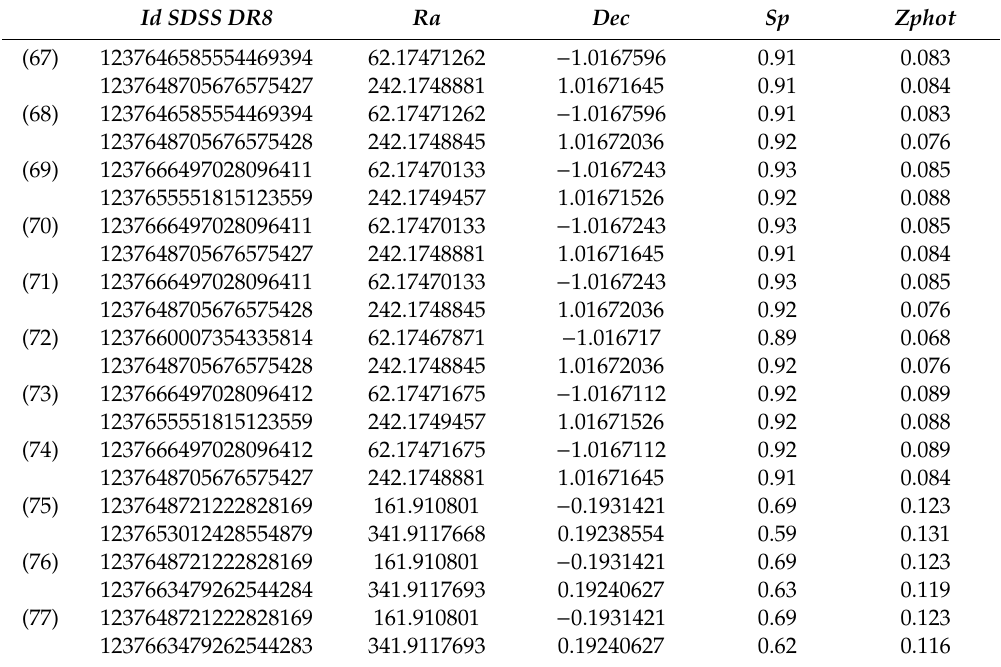
Table A6. Pairs of galaxies for the e ff ect of cosmic mirror from catalog [41]—alternative approach.